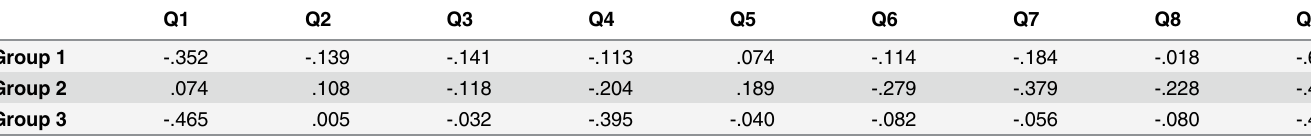
Table 4. Zero-order correlation coefficients between TPB items and behavioural